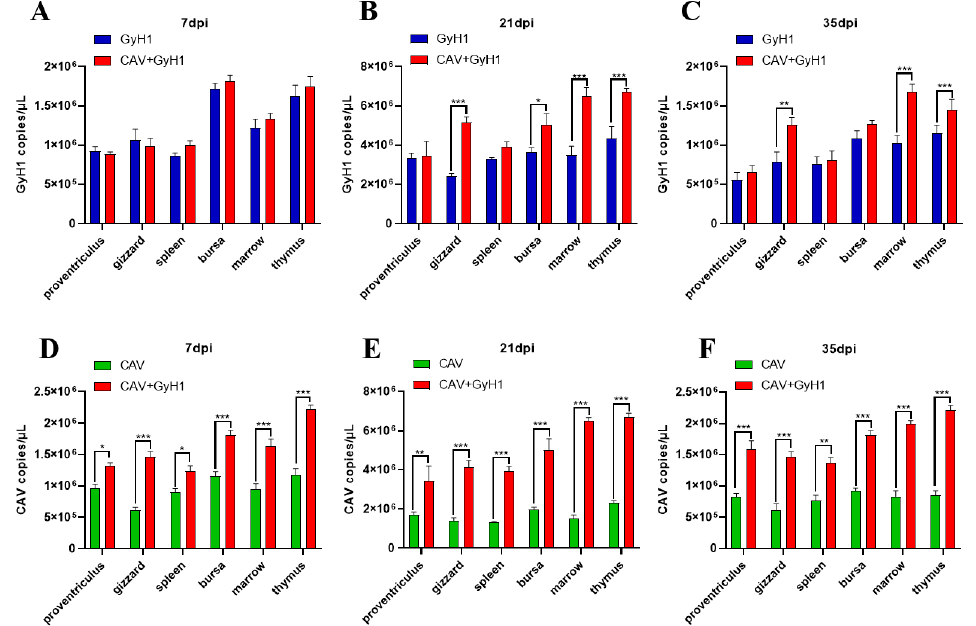
Figure 5. Comparison and dynamic changes of viral loads in infected chicken tissues. ( A – C ) Comparison of organ GyH1 viral loads between the GyH1- and co-infected chickens, determined by qPCR. ( D – F ) Comparison of organ CAV viral loads in CAV- and co-infected chickens, determined by qPCR. * , p < 0.05; ** , p < 0.01; *** , p < 0.001, (Student’s t